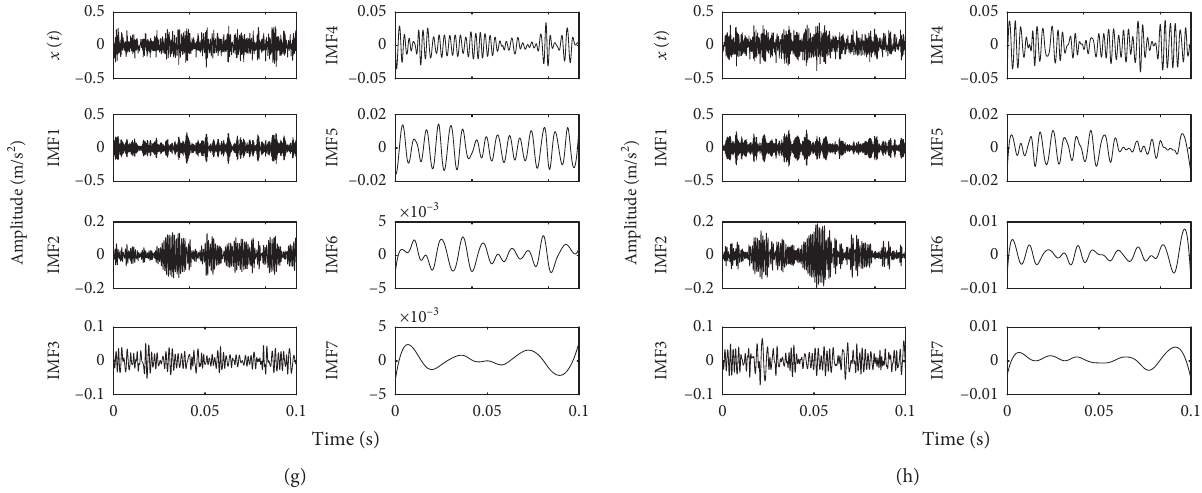
Figure 3: The EEMD results of eight states. (a) N. (b) I-D. (c) B-D. (d) O6-D. (e) I-F. (f) B-F. (g) O3-F. (h) O12-F.